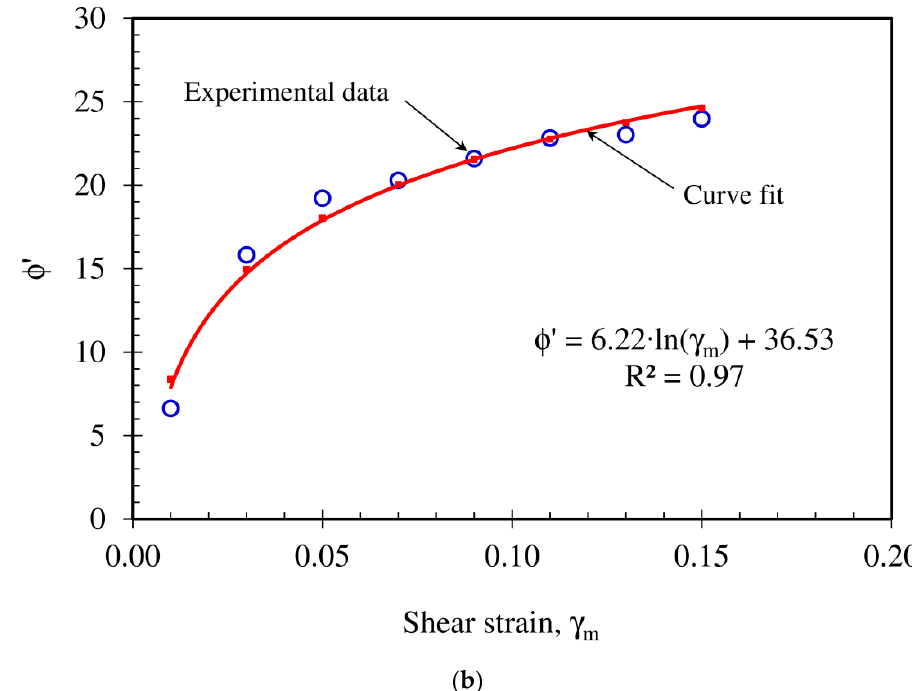
Figure 7. ( a ) Variation trend of c ′ , as a function of the monotonic shear strain ( γ m ); ( b ) variation trend of ϕ′ , as a function of the monotonic shear strain ( γ m ).